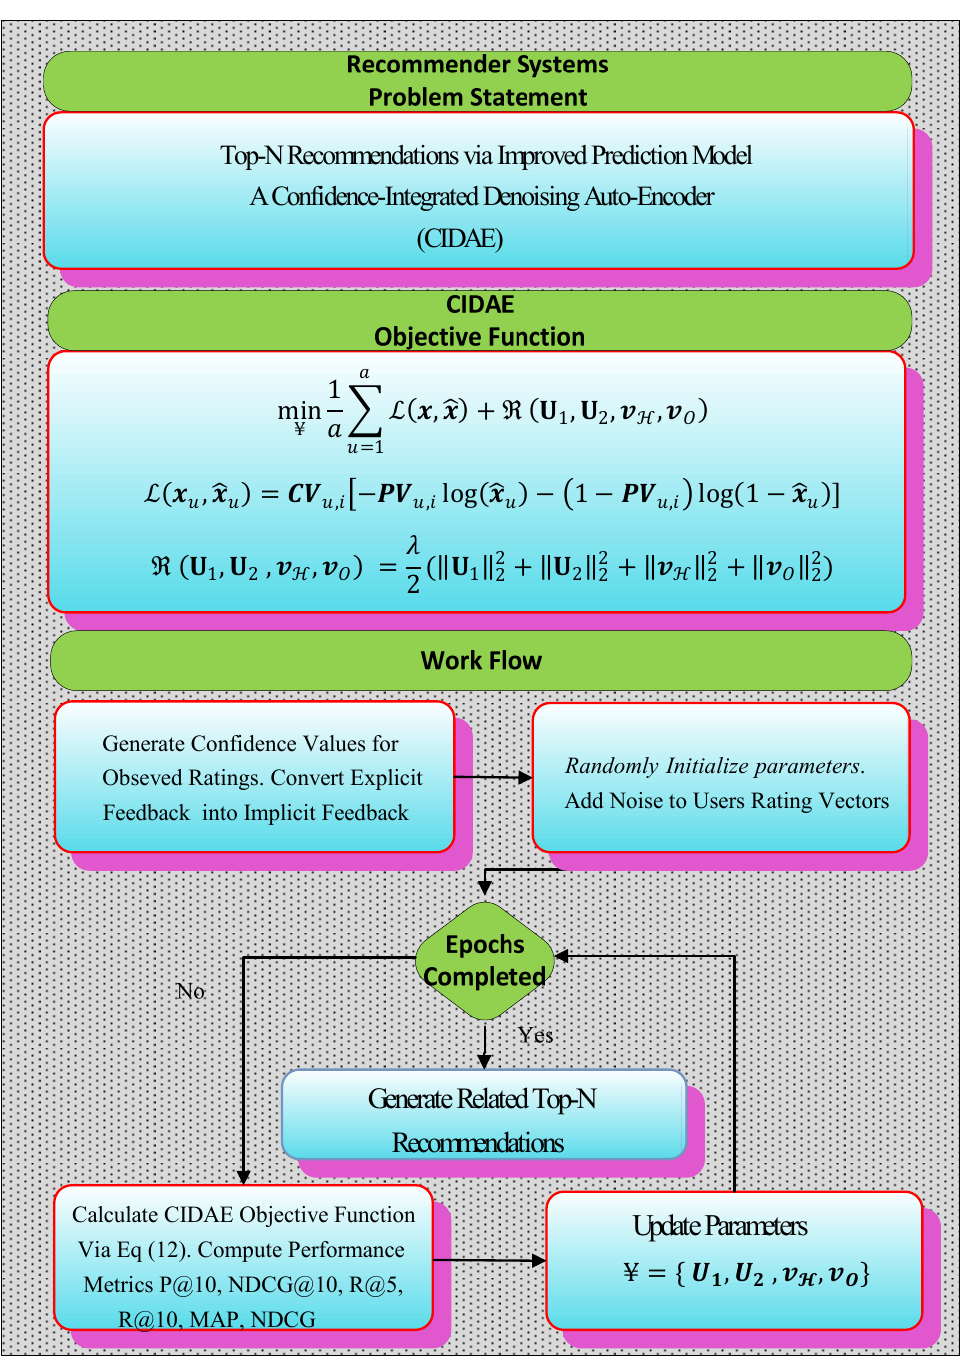
Figure 5. Graphical flow of the proposed CIDAE for top ‐ N recommendations